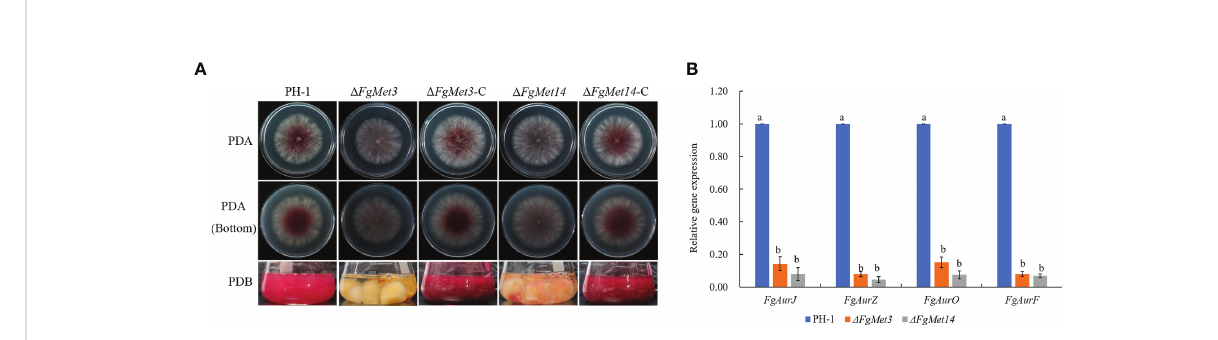
FIGURE 6 Pigment formation of PH-1, FgMet3 or FgMet14 deletion mutants and their complements. (A) All the strains were cultured on PDA medium for 2d and cultured in PDB medium for 3d to produce pigment. (B) Relative expression levels of Aurofusarin biosynthesis-related genes FgAurJ, FgAurZ, FgAurF, and FgAurO in the D FgMet3 and D FgMet14 mutants compared with the WT strain. Bars with the same letter indicate no signi fi cant difference according to the least signi fi cant difference (LSD) test. P =